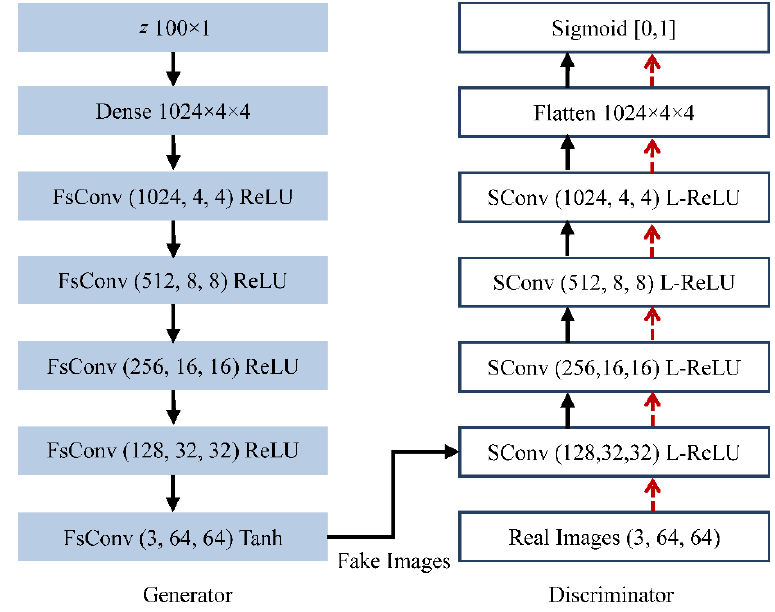
Figure 2. Architecture of DCGAN (Deep Convolutional Generative Adversarial Networks) for Faces database in Reference [22], where FsConv represents fractionally-strided convolutions; SConv is the acronym for strided convolutions; (1024, 4, 4) represents 1024 filters and the size of the convoluted image is 4×4; ReLU, Tanh, and L-ReLU are three types of activation functions, i.e., ReLU, Tanh, and Leaky-ReLU.